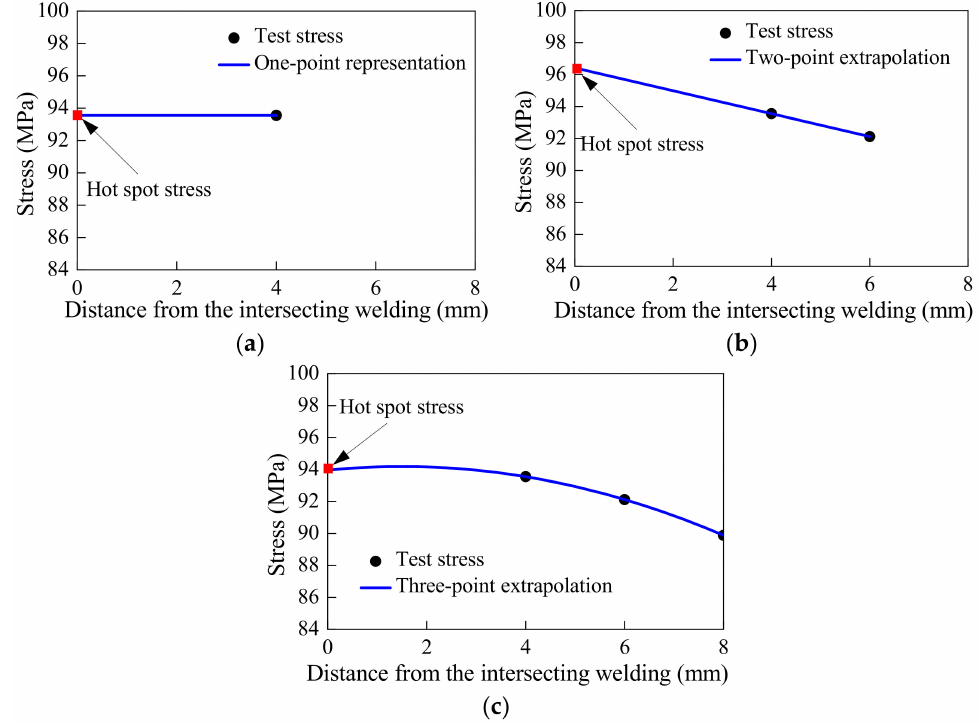
Figure 8. Comparison of hot-spot stress determination methods: ( a ) one-point representative method; ( b ) two-point extrapolation method; and ( c ) three-point extrapolation